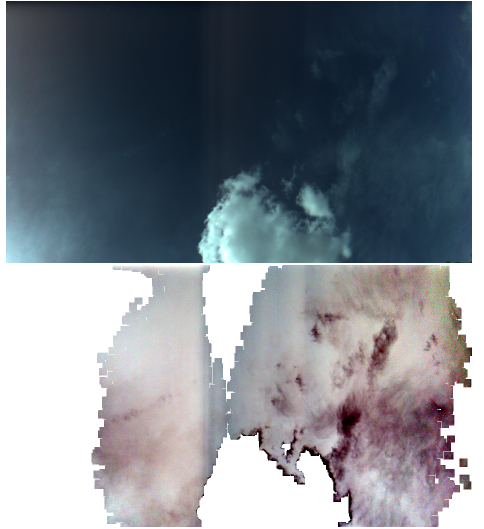
Figure 6: Original image (top) and difference between the esti- mated Perez model and the blue sky pixels (homogeneous white areas are those not detected as blue sky; the display settings are chosen for enhancing contrast).